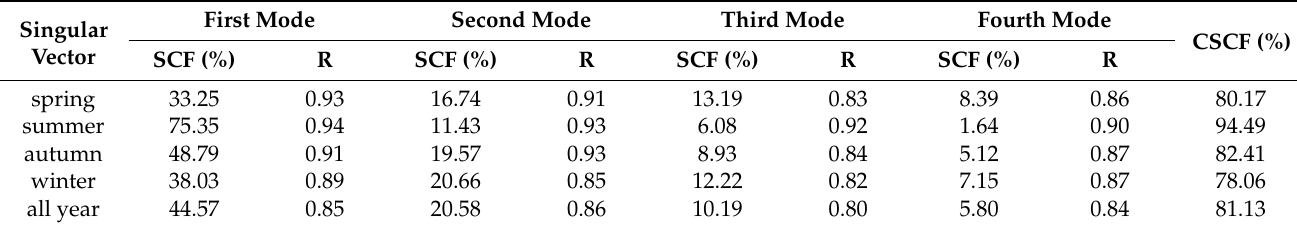
Table 1. SVD results of sensible heat field and water vapor flux divergence